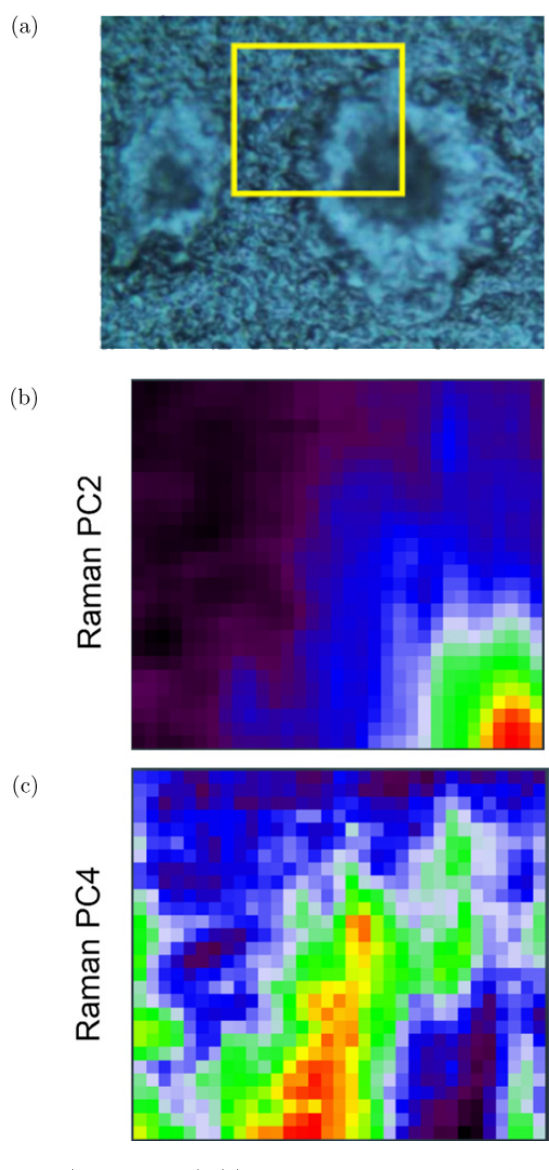
Fig. 6. (Color online) (a) Photomicrograph of a TASTPM mouse brain hippocampal section containing two plaques. (Yellow box denotes a 46 (cid:1) 39 (cid:2) m 2 area where a Raman map was acquired using a 1.4 (cid:2) m step-size). (b, c) Map scores of the principal components (PCs) obtained from the analysis of the micro-Raman map. Red color region in (b) denotes the plaque core, whilst in (c) it denotes the lipid-loaded ring surrounding the